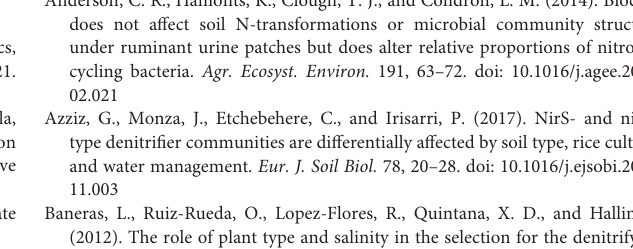
Supplementary Figure 1 | Rank abundance curves for (A) nirK - and (B) nirS -type denitrifying bacterial operational taxonomic unit (OTU) diversity in rhizosphere soil of not inoculation Quercus aliena (CK.ali) and Q. aliena inoculated with Tuber melanosporum (mel.ali) or Tuber indicum (ind.ali). Supplementary Figure 2 | Rarefaction curves of (A) nirK - and (B) nirS -OTUs in the rhizosphere of not inoculated Q. aliena (CK.ali) and Q. aliena inoculated with Tuber melanosporum (mel.ali) or Tuber indicum (ind.ali). Supplementary Figure 3 | The Shapiro-Wilk test for normality of (A) morphological indices and (B) physiological indices of Quercus aliena seedlings, (C) soil properties, and (D) richness and diversity of nirK - and nirS -denitrifiers. Supplementary Figure 4 | Differential abundance analysis of nirK - and nirS -OTUs in the rhizosphere of not inoculated Q. aliena (CK.ali) and Q. aliena inoculated with Tuber melanosporum (mel.ali) or Tuber indicum (ind.ali). (A) nirK -OTUs in CK vs. mel.ali, (B) nirK -OTUs in CK vs. ind.ali, (C) nirK -OTUs in ind.ali vs. mel.ali, (D) nirS -OTUs in CK vs. mel.ali, (E) nirS -OTUs in CK vs. ind.ali, and (F) nirS -OTUs in ind.ali vs. mel.ali. The x-axes show median log2 dispersion within treatments and the y-axes median log2 difference between